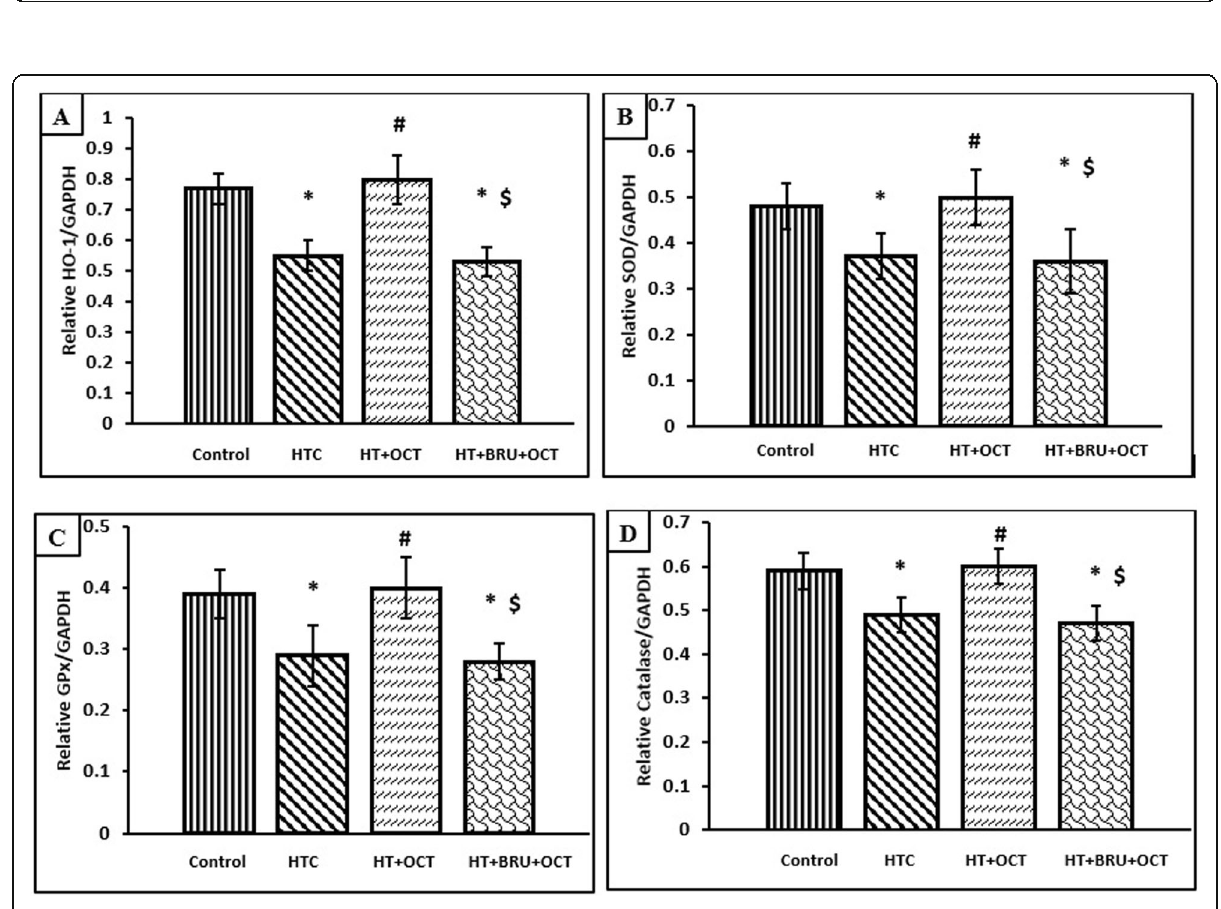
Fig. 5 Effect of octreotide on Nrf2-regulated gene expressions of HO-1 ( a ), SOD ( b ), GPx ( c ), and catalase ( d ) in rat hearts exposed to ischemia for 30 min and reperfusion for 120 min. Data are represented as mean ± standard deviation. Significance ( P < 0.05): *significant when compared with the control group, # significant when compared with HTC group, $ significant when compared with